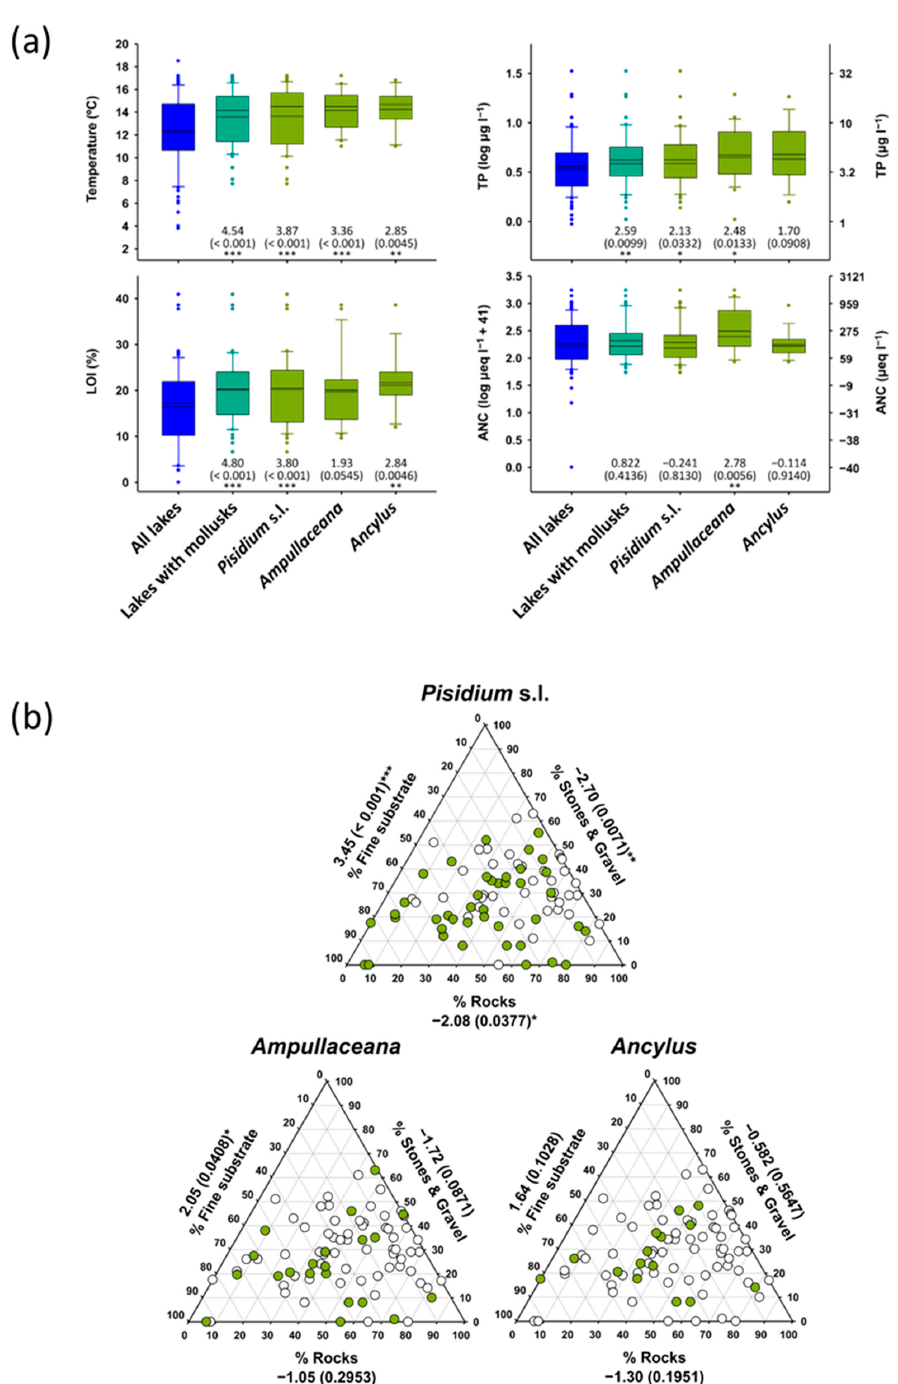
plots) occurred at increasing temperatures from Pisidium s.l. (10 ◦ C) and Ampullaceana (12 ◦ C) to Ancylus (14 ◦ C). The same occurred for LOI, Pisidium s.l. (8%), Ampullaceana (18%), and Ancylus (20%). Therefore, shifting to warmer and more organic conditions will particularly favor the expansion of Ampullaceana and Ancylus .